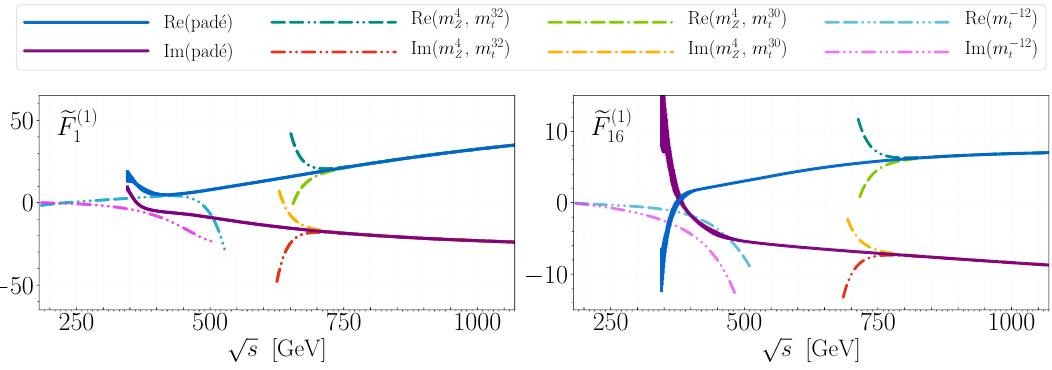
Figure 6 . The NLO form factor of the tensor structures T 1 and T 16 as a function of p s , plotted for (cid:18) = (cid:25)= 2. Both the real and imaginary parts are shown. Dash-dotted and dotted lines correspond to the high-energy and large- m t results. The solid lines/bands represent the Pad(cid:19)e-improved predictions and their